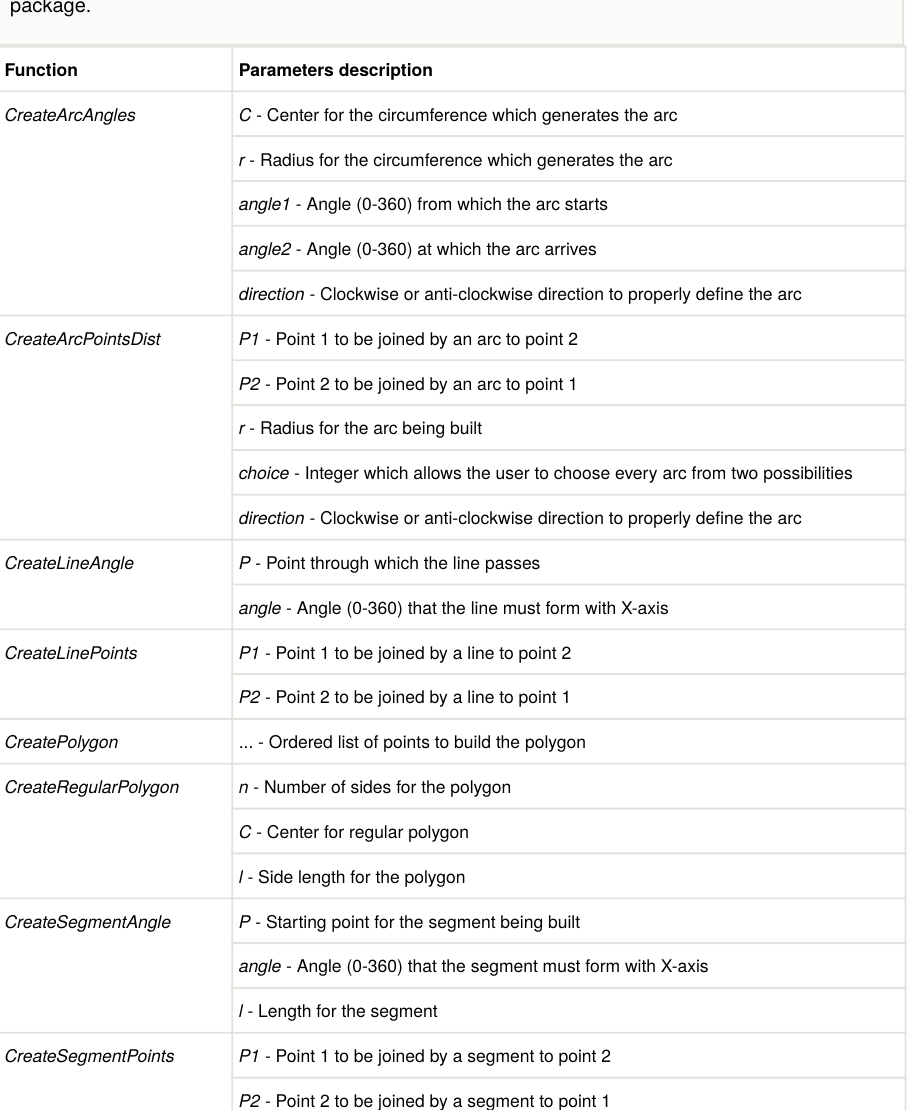
Short description of all the parameters available in the basic functions of the LearnGeom R